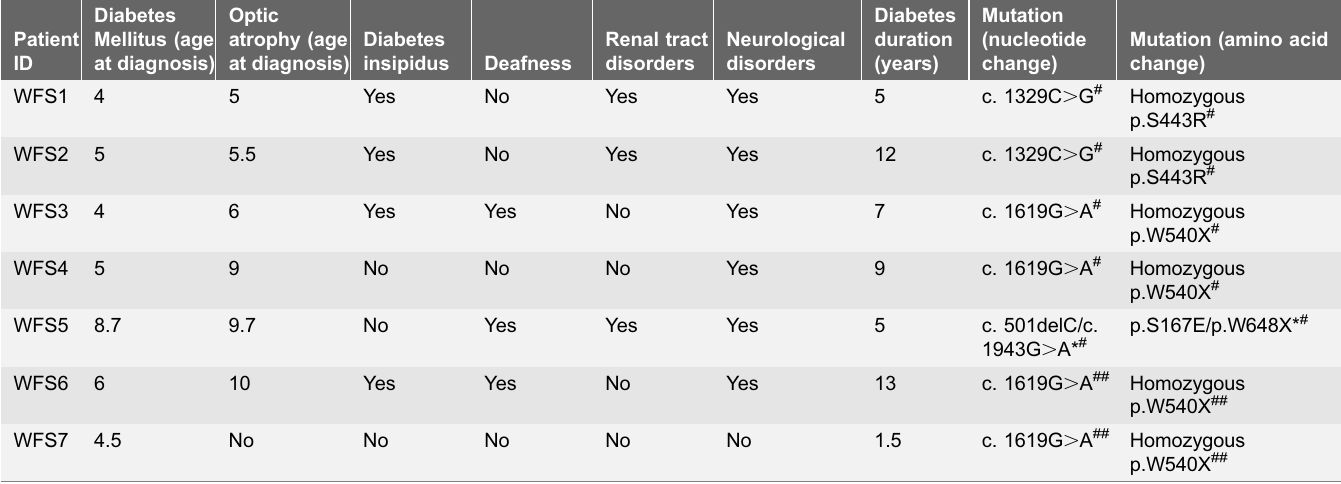
Table 1. Clinical and genetic characteristics of patients with Wolfram syndrome (16,